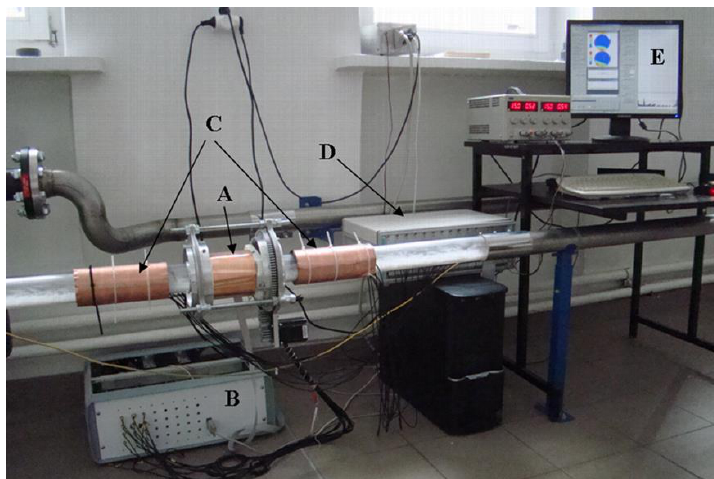
Figure 2. General view of the experimental stand: ( A ) rotatable sensor, ( B ) ECT acquisition unit, ( C ) dual plane for solids flow velocity estimation, ( D ) dual-plane 16 AC-base electrical capacitance tomography (ECT) acquisition unit, ( E ) screen that displays both software of the tomography